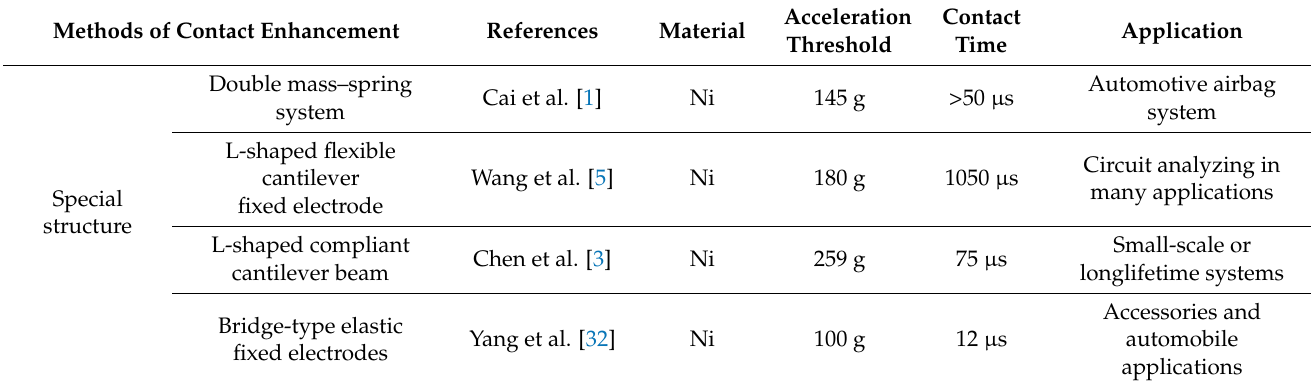
Table 4. A summary of some examples of typical contact-enhanced inertial switch